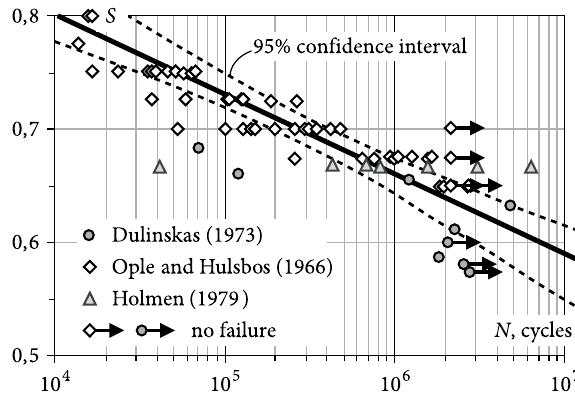
Fig. 5. The Wöhler ’s diagram with 95% confidence limits, based on the experimental results reported by Dulinskas (Дулинскас 1973), Ople and Hulsbos (1966), and Holmen (1979)